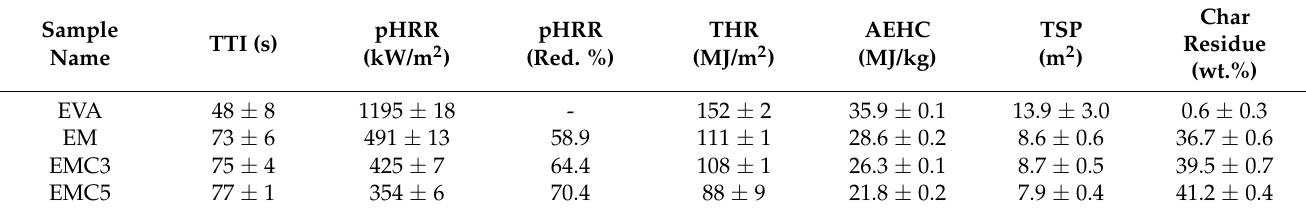
Table 7. Cone calorimetry results of the